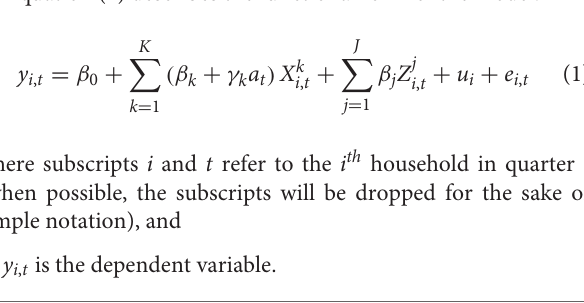
TABLE 2 | Dataset description and measurement of consumer responses to COVID-19.